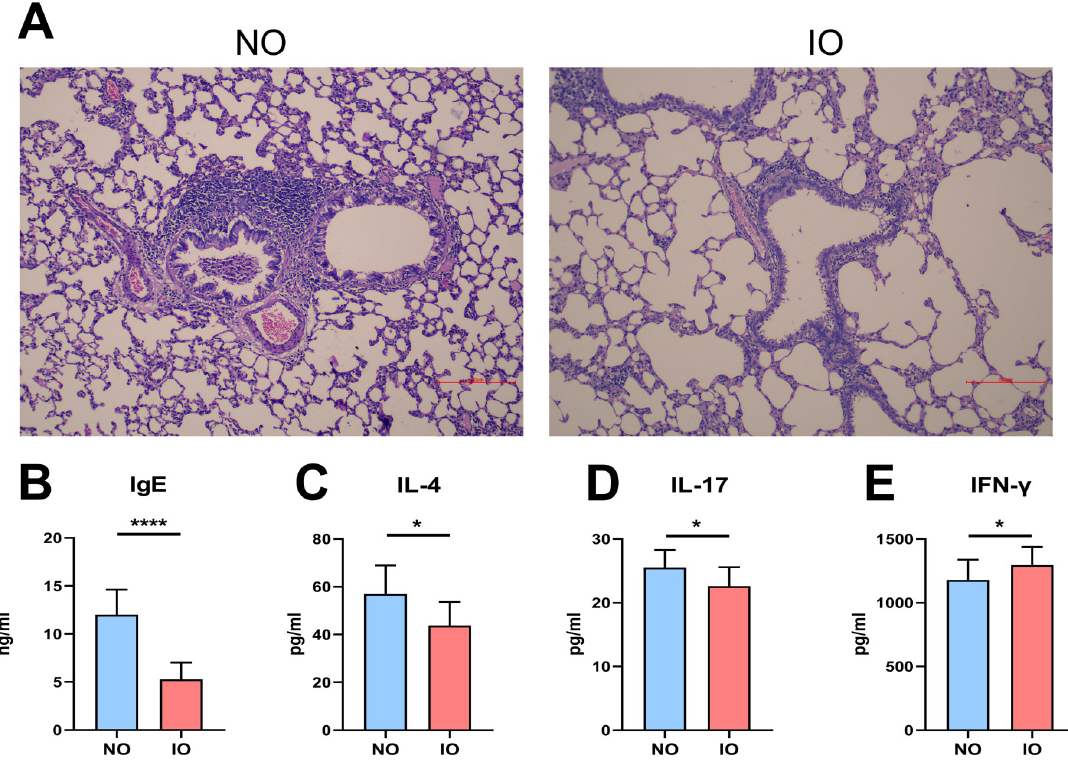
Fig 1. Inulin is able to reduce lung inflammation and related cytokine production in the offspring. (A) The pulmonary inflammation in NO group was significantly worse than that in IO group; The level of IgE (B), IL-4 (C) and IL-17 (D) in NO group was higher than that in IO group (B: p < 0.0001, C: p < 0.05, D: p < 0.05); (E) The INF- γ level in IO group was higher than that in NO group (p <